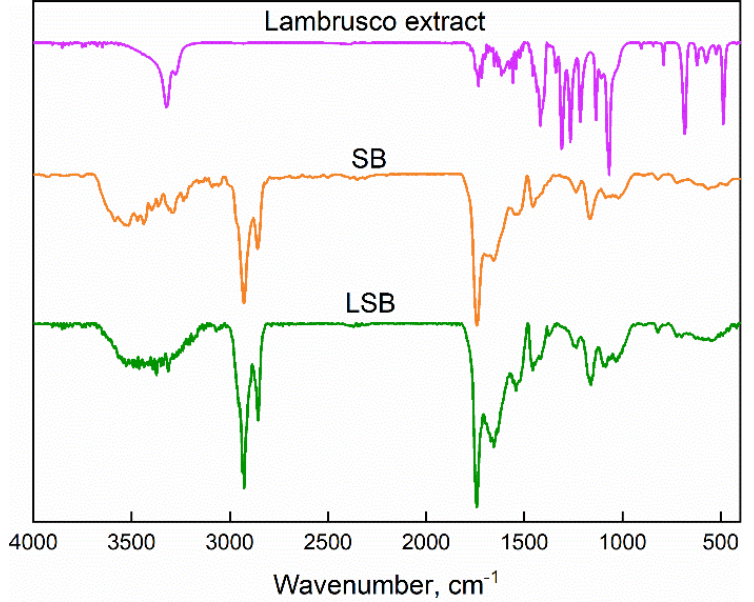
Figure 3. FTIR spectra of Lambrusco extract and soybean extract-based beads.